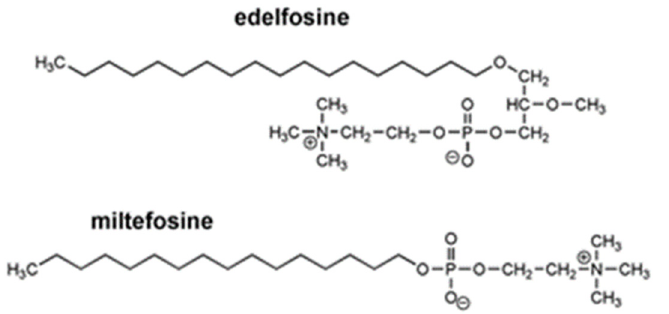
Figure 1. Molecular structures of edelfosine and miltefosine. Edelfosine (2-methoxy-3-(octadecyloxy) propyl 2-(trimethylazaniumyl)ethyl phophate) is a synthetic alkylphospholipid (APL). Miltefosine (hexadecyl 2 ‐ (trimethylazaniumyl)ethyl phosphate).